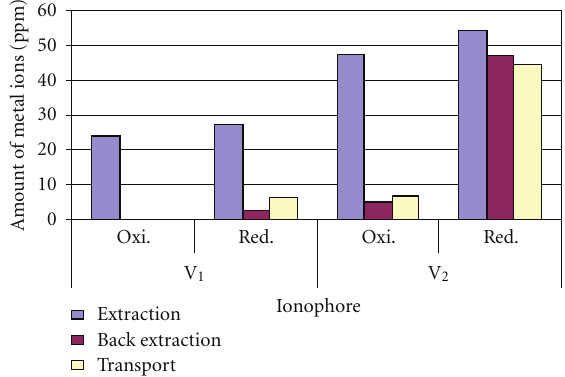
Figure 8: Extraction, back extraction, and transport of K + by ionophores V 1 and V 2